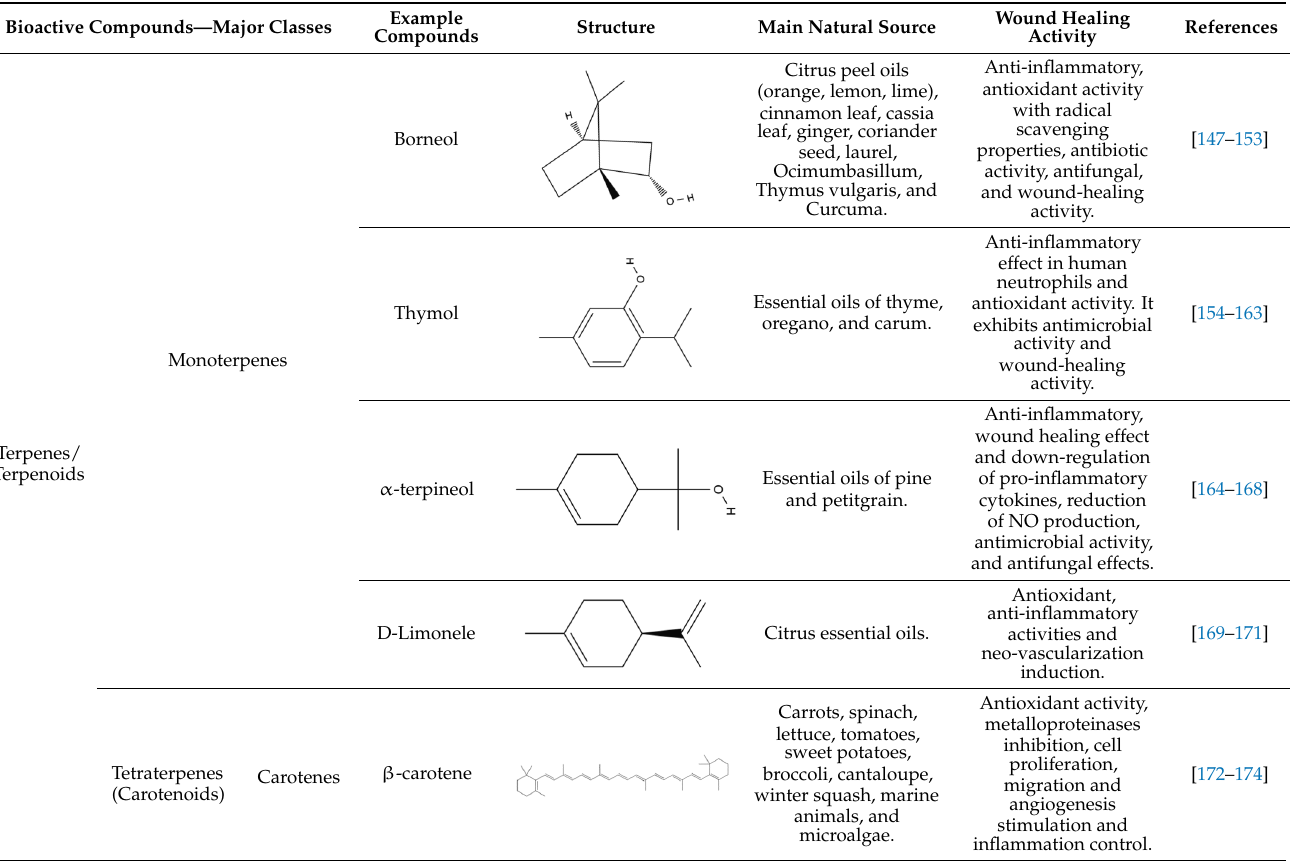
Table 2. Major classes of natural bioactive compounds, structure, main sources, and their therapeutic targets for wound-healing activity.